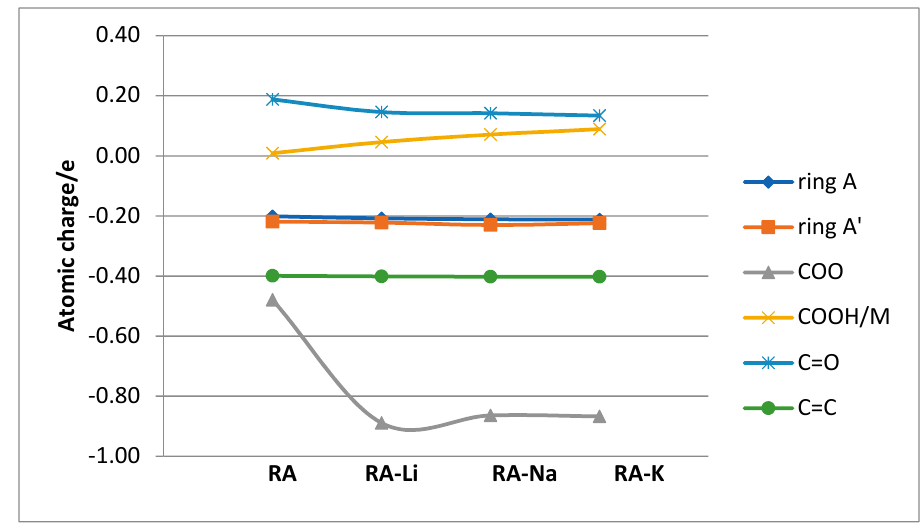
Figure 3. The atomic charges calculated for chosen groups of studied molecules.